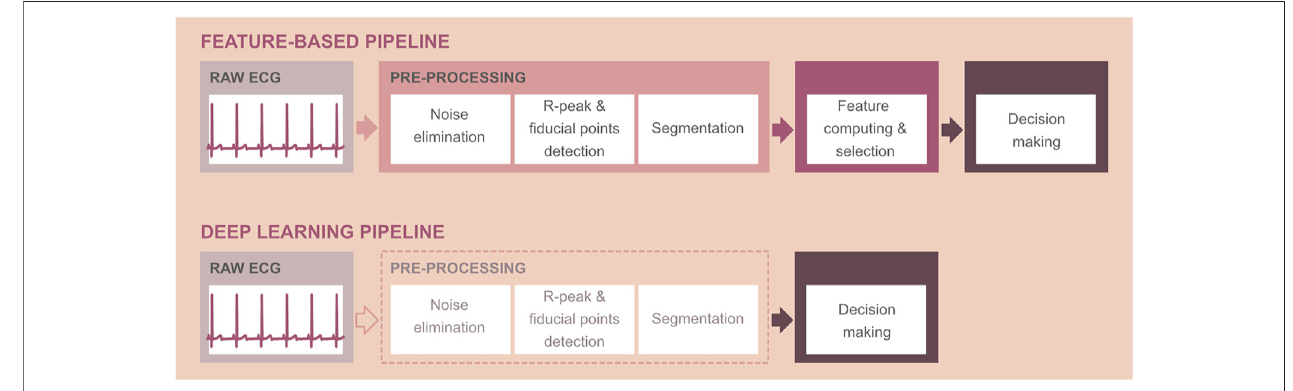
FIGURE 3 | Schematic representation of computer-aided ECG interpretation using feature-based technique (top) and deep learning approaches, which do not require the calculation of ECG features (bottom). Note: pre-processing steps are optional when using deep learning methods and depend on the application.